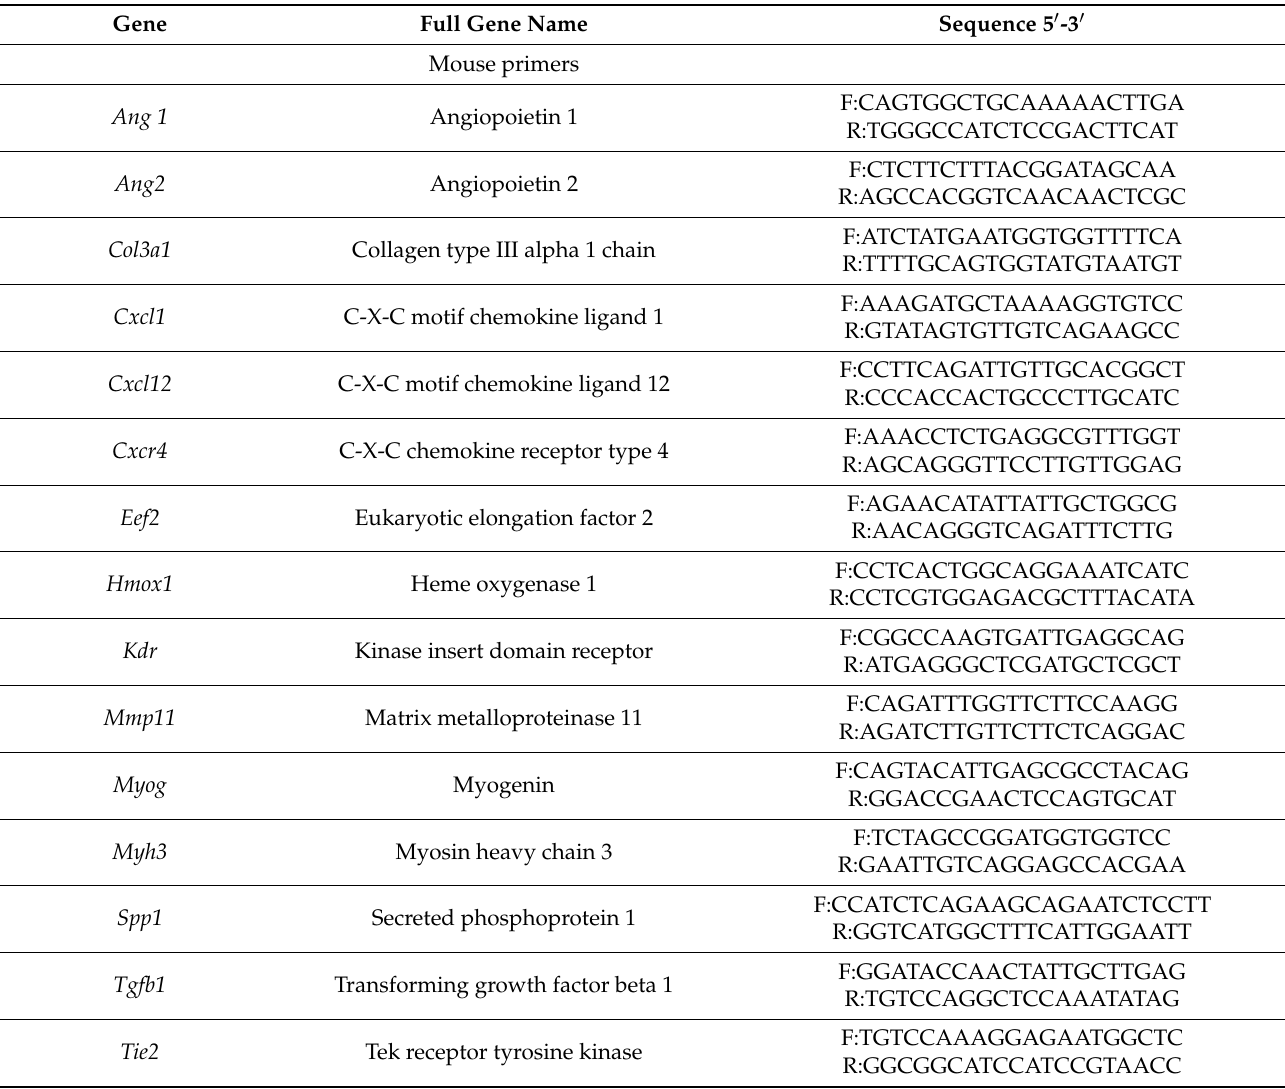
Table 1. The sequences of forward (F) and reverse (R) primers used in quantitative real-time PCR (qRT-PCR.)